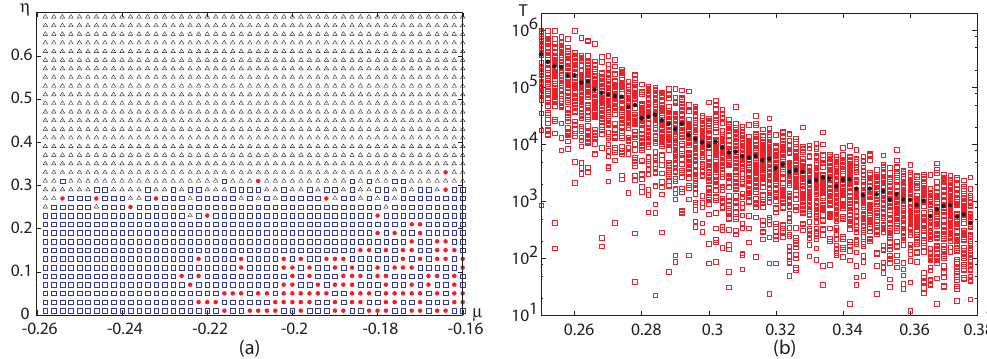
Figure 3. Phase diagram: Influence of multiplicative noise on exploding solitons for a fixed time scale T = 10 4 . ( a ) Black triangles ( (cid:52) ) denote collapsed states. Red solid circles ( • ) stand for exploding dissipative solutions and blue squares ( (cid:3) ) for oscillating localized solutions. ( b ) Collapse time for exploding dissipative solitons under the influence of multiplicative noise for µ = − 0.18. The average time scale T for collapse is shown as a function of the noise strength η . Black solid circles ( • ) represent an average over 50 realizations shown as open squares ( (cid:3)